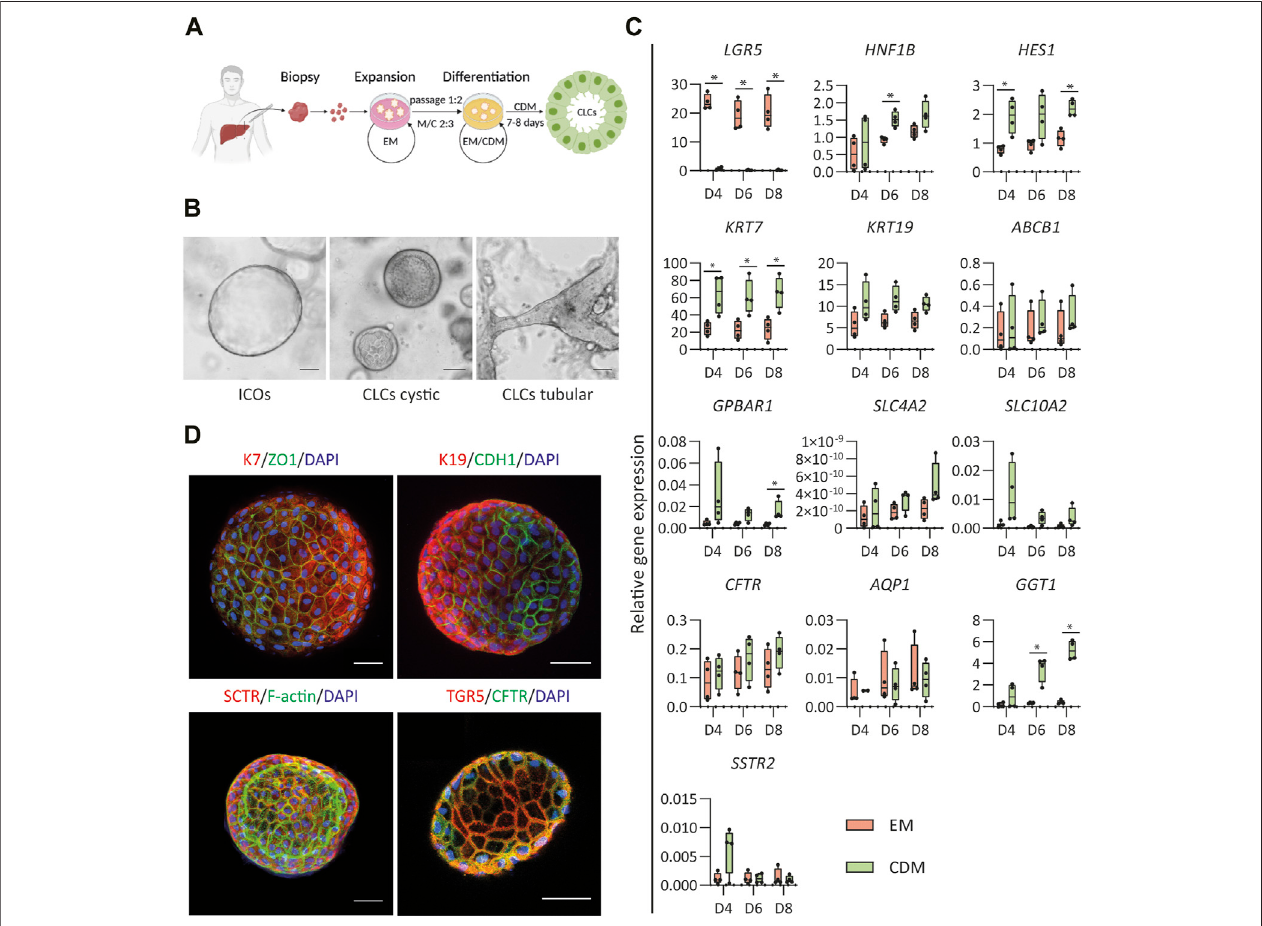
FIGURE1| Differentiationofhumanintrahepaticcholangiocyteorganoids(ICOs)towardcholangiocyte-likecells(CLCs). (A) Schematicoverviewoftheprotocolfor differentiation of human ICOs to CLCs. EM, expansion medium; CDM, cholangiocyte differentiation medium; M/C, Matrigel/collagen type Ⅰ mixture. (B) ICOs in EM condition and cystic/tubular structures of CLCs formed in CDM. Left, ICOs; Middle, CLCs cystic; Right, CLCs tubular structure. Scale bar = 100 μ m. (C) Gene expression analysisfor ICOs under EMand CDMconditions. N=4 independent donors forEM and CDM conditions at three time points (days 4,6, and 8). Results areshownasfoldchangerelativetothehumangallbladderforcholangiocytemarkersandthelivertissueforadultstemcellmarkers.Dataareshownasboxandwhisker